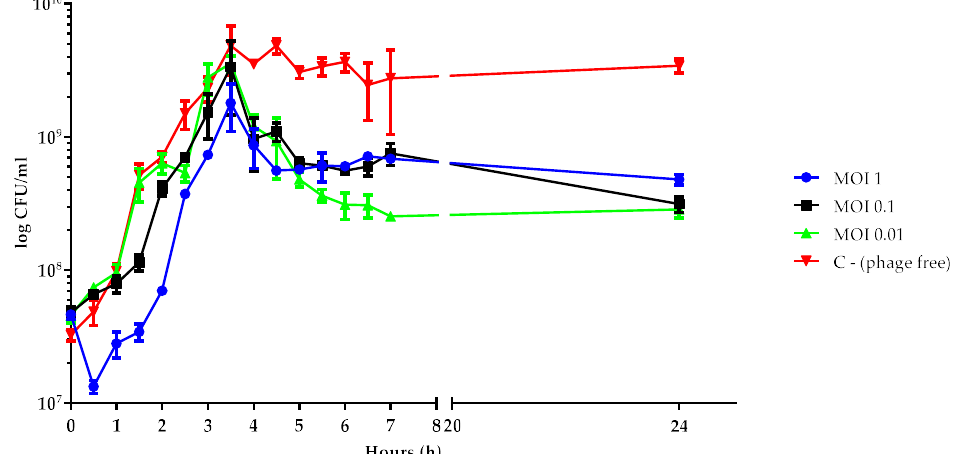
Figure 5. Time-kill assays with bacterial host in exponential phase. Viable cell count (log CFU/mL) of 12C47 cultures infected with vB_Kpn_F48 at MOI of 1 (blue), MOI of 0.1 (black), MOI of 0.01 (green) and the uninfected control (red) are shown. Each data point is the mean from three experiments. Standard deviations are shown as vertical lines.